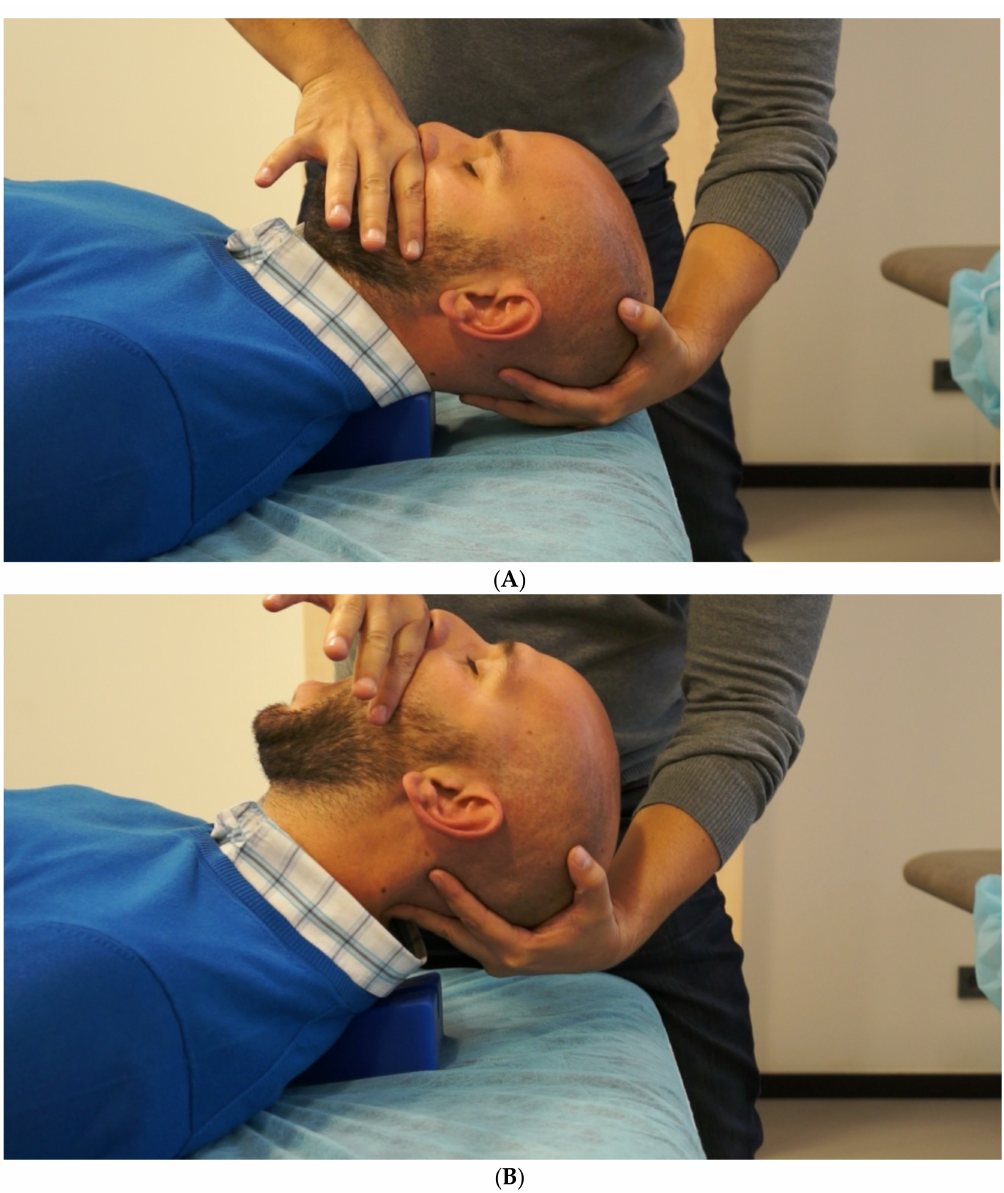
Figure 2. ( A ) Neural mobilization (step 1). Craniocervical flexion; ( B ) neural mobilization (step 2). Craniocervical extension plus mouth